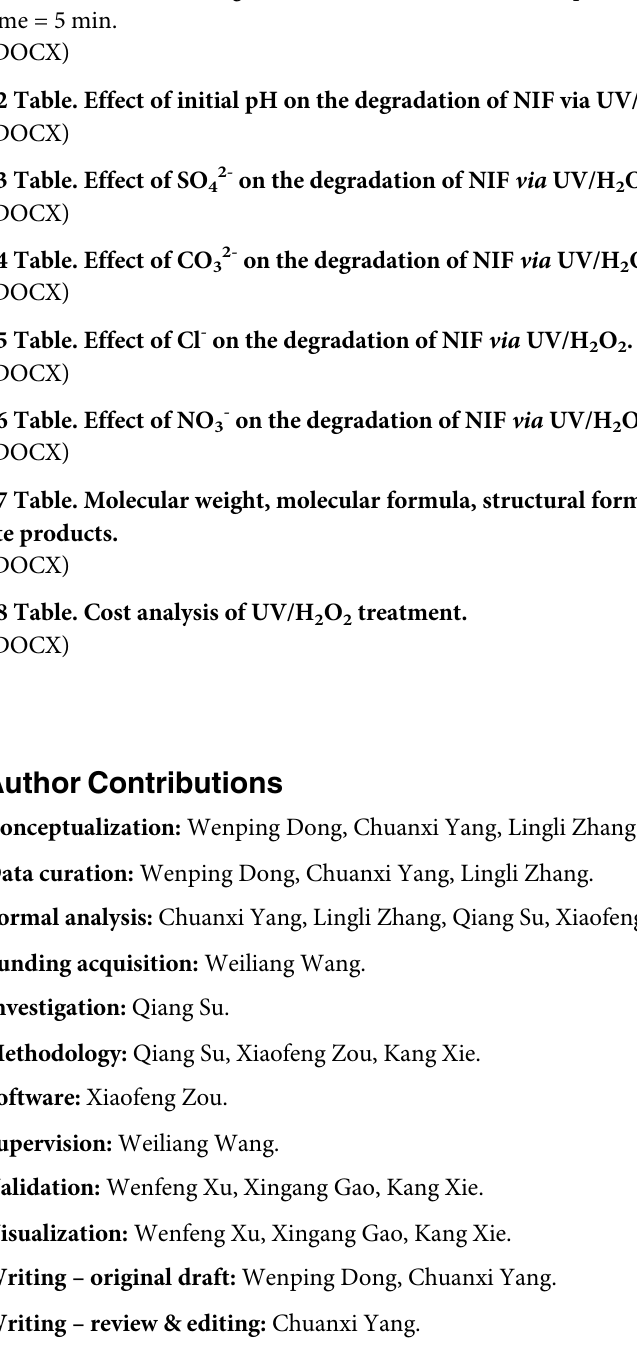
O dose on the degradation of NIF via UV/H 2 2